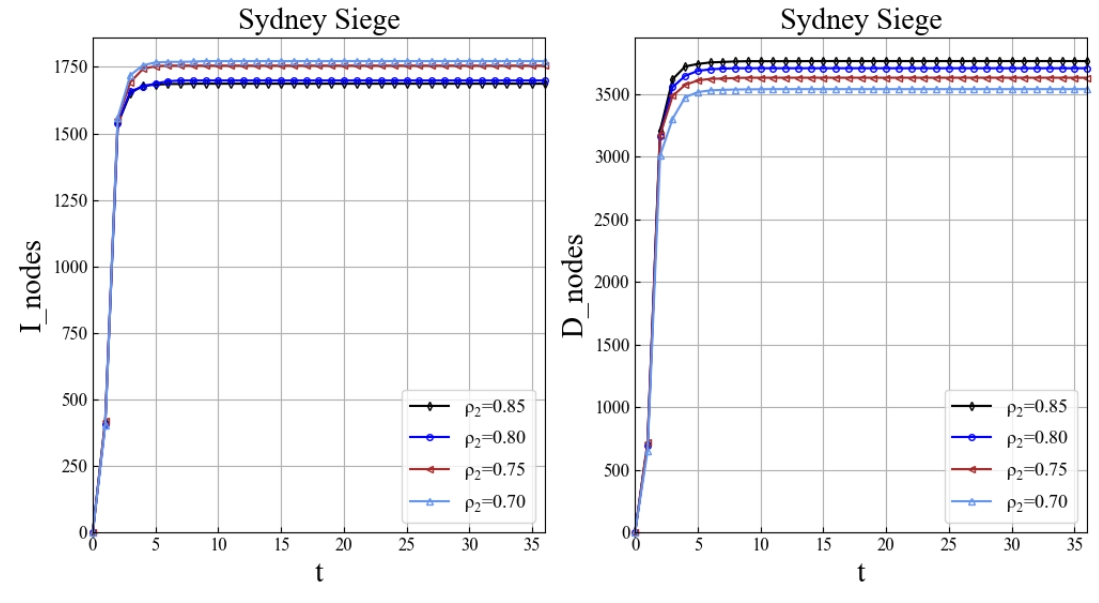
Figure 5. The analysis of the self-identification